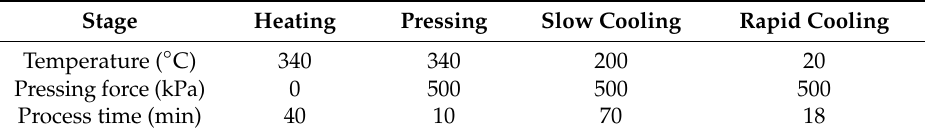
Table 2. Nano-imprinting conditions and process parameters used in this study.